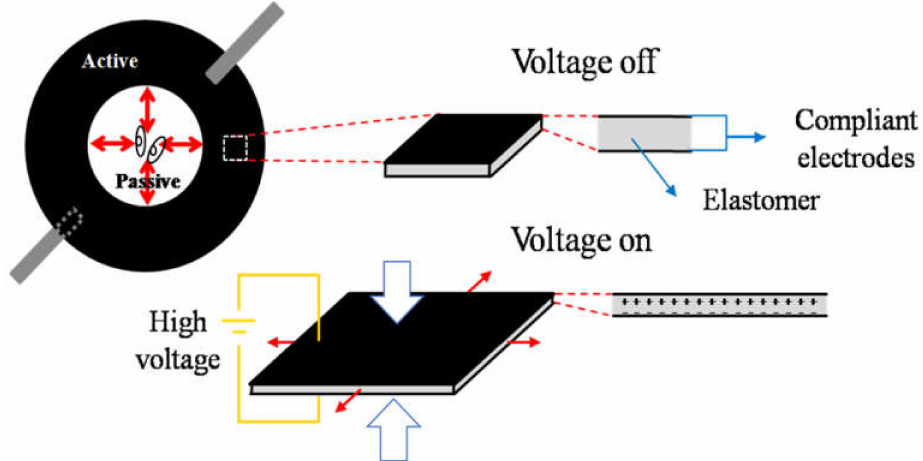
Figure 1. Dielectric elastomer (DE) operating principle. The radial electrode configuration distinguishes the annular (peripheral) active and circular (central) passive zones. The application of voltage across the electrodes squeezes the film between the electrodes due to the electrostatic attraction between the electrode pair. The transversal compression causes a longitudinal extension of the active zone (tensile strain). Consequently, the passive zone compresses (compressive